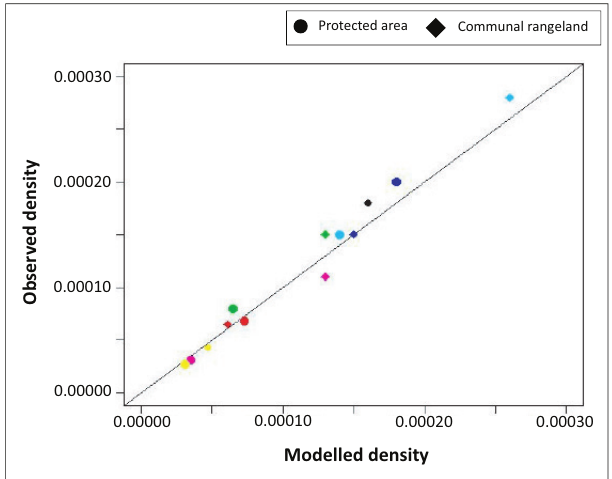
FIGURE 7-A1: The relationship between the observed and modelled bird densities in protected areas and communal rangelands for seven surrogate species groups after Coetzee et al. (2016). Black represents surrogate bird species group 1, red – group 2, green – group 3, blue – group 4, turquoise – group 5, pink – group 6, and yellow – group 7. See Figure 5-A1 for the definition of groups. The two different land-use types are indicated by different symbols, as shown in the legend. The diagonal line with a slope of one to one shows the hypothetical line of best fit if observed density = modelled density. (Pearson’s r = 0.989; p < 0.001).